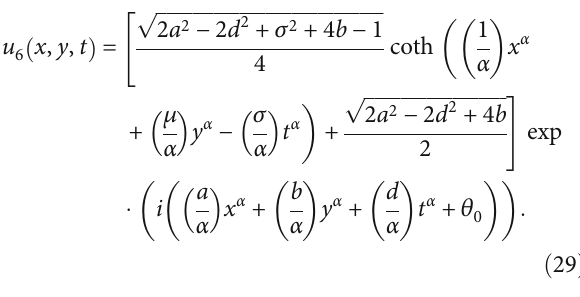
Figure 6: Graphical representation of solution u (23) for t = 0 :: 5, x = − π :: π , for α = 0 : 2 .